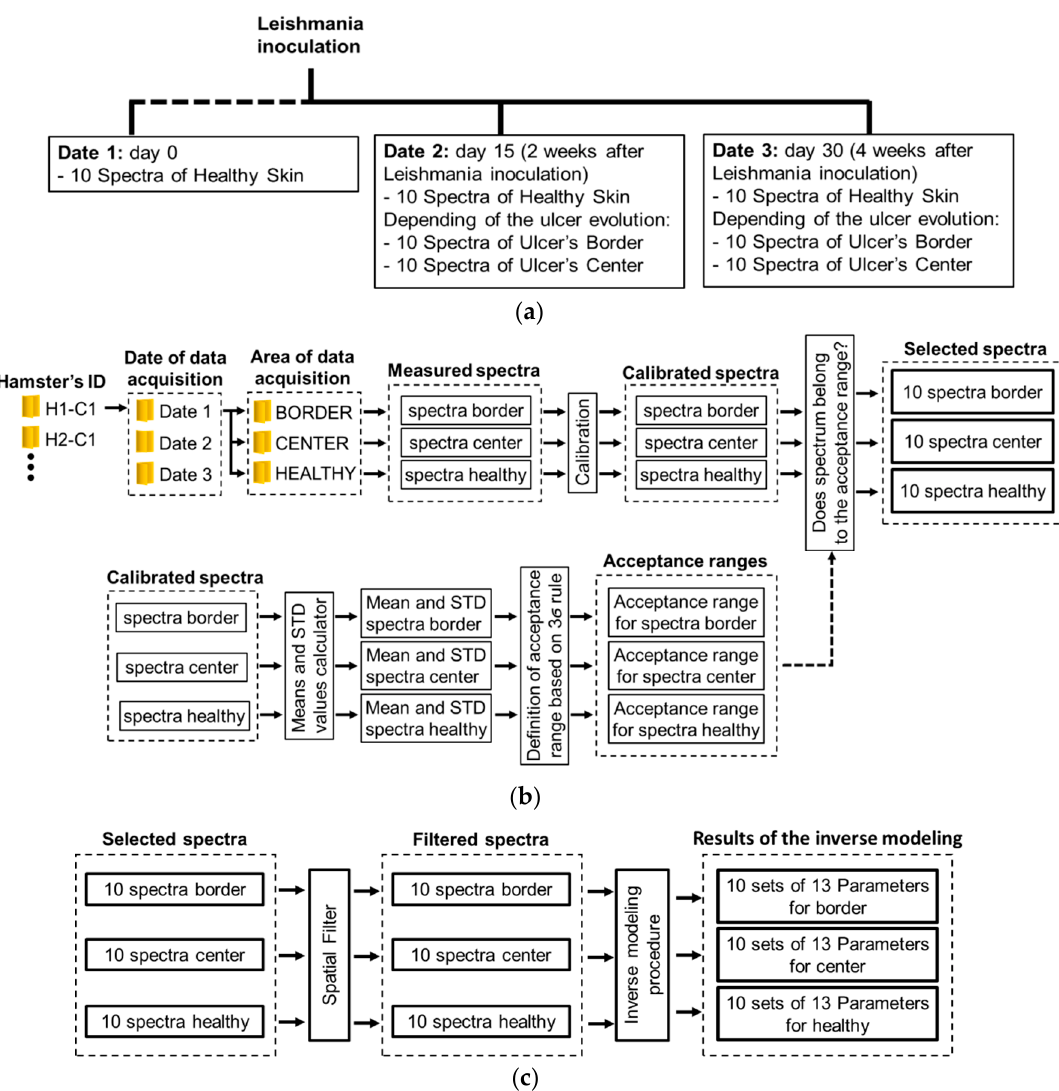
Figure 2. ( a ) chronology of data acquisition in golden hamster’s healthy and ulcerative skin lesion due to cutaneous leishmaniasis (CL). ( b , c ) procedure for processing of the acquired spectra.